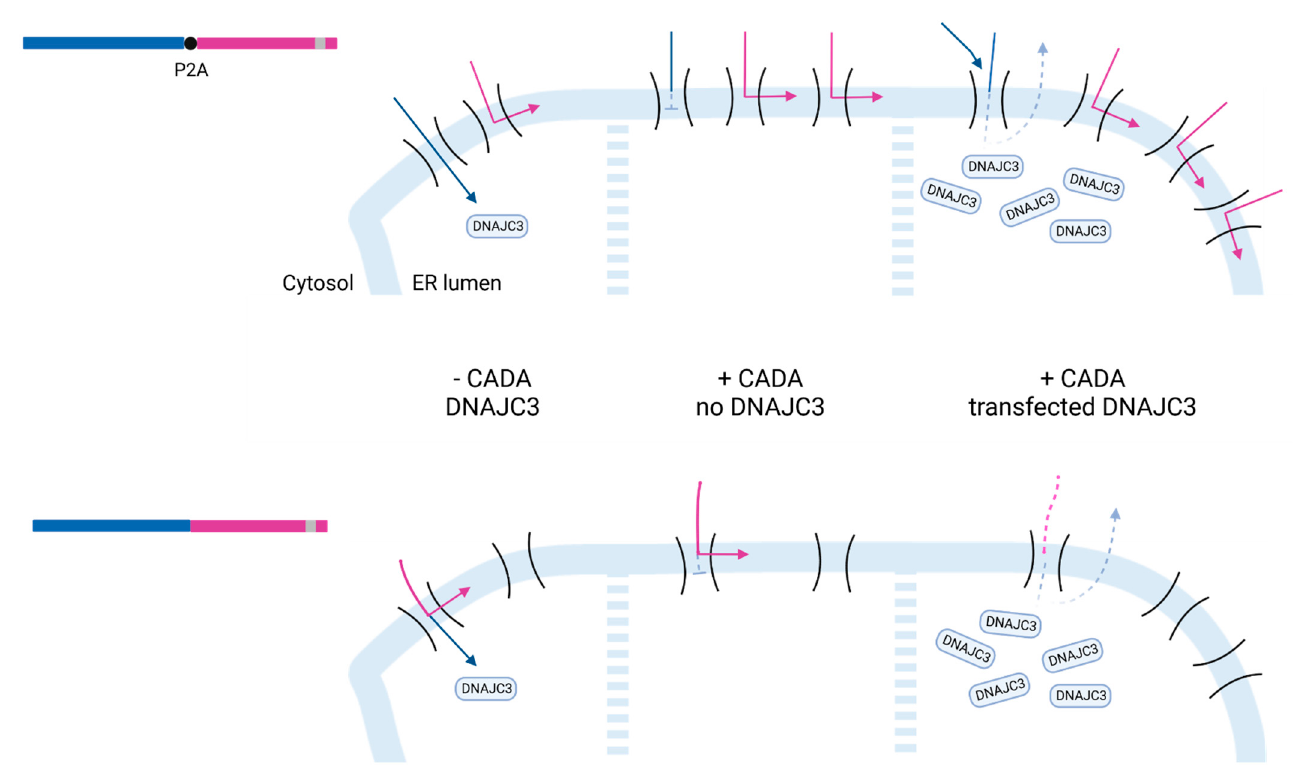
Figure 7. Proposed model of co-translational translocation events in the presence of CADA and DNAJC3. Top panel: The ERLEC1-P2A-mCD4 construct was translated by the ribosome and was targeted to the ER membrane with import into the ER lumen of the ERLEC1 protein (blue arrow) and insertion of mCD4 in the ER membrane (pink arrow). Under CADA pressure, ERLEC1 was prevented from being translocated (clogged translocon) while mCD4 could still get inserted into the ER membrane via its own SP, with even higher efficiency. When DNAJC3 was highly expressed, the ERLEC1 clogged translocon was rapidly cleared, allowing insertion of more mCD4 in the ER membrane while ERLEC1 translocation was consistently inhibited by CADA. Bottom panel: The ERLEC1-mCD4 construct was translated but the ER targeting and membrane insertion of mCD4 was at a very low level. Treatment with suboptimal levels of CADA stabilized the targeting complex and enhanced the targeting and membrane insertion of mCD4, whereas, at high CADA concentra- tion, the translation and translocation of mCD4 were slightly down-regulated. The presence of high DNAJC3 levels rapidly removed (and degraded) the stalled ERLEC1 species (and downstream mCD4 protein) and prevented the stalled mCD4 from eventually getting inserted into the ER mem- brane, thus, intensifying the net down-modulating effect of CADA on its substrates.